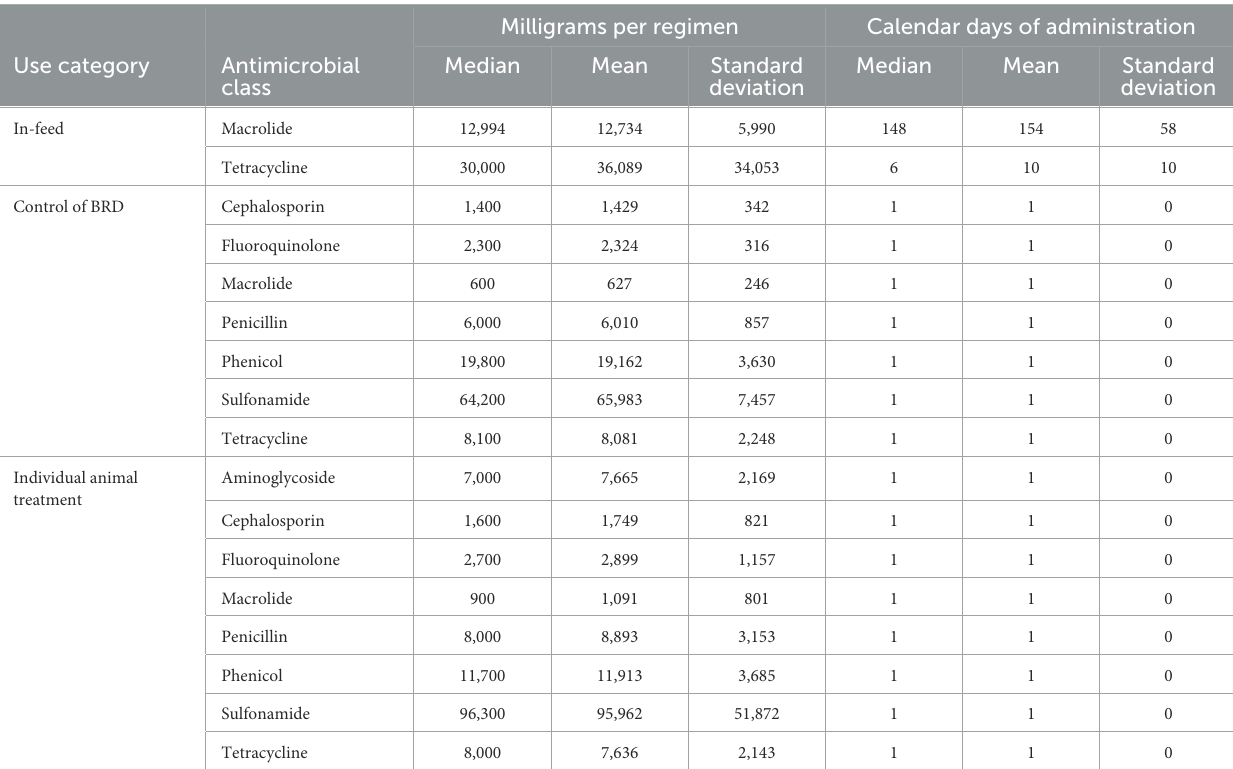
TABLE 4 Regimens described as milligrams of drug per regimen and calendar days of administration per regimen grouped by antimicrobial class within use category. Milligrams per